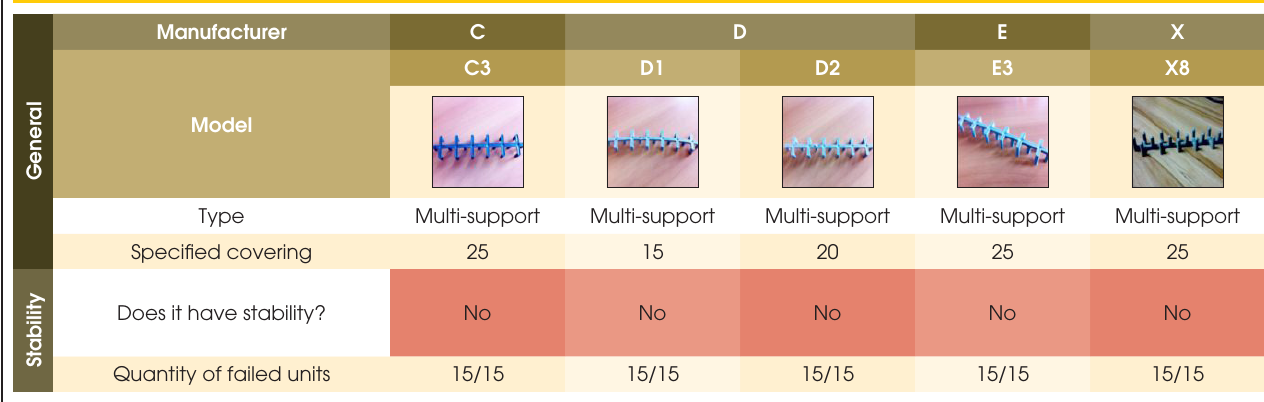
Table 17 – Results of the stability requirement evaluation of the multi-support-type spacers of the manufacturers C, D, E and unknown manufacturers